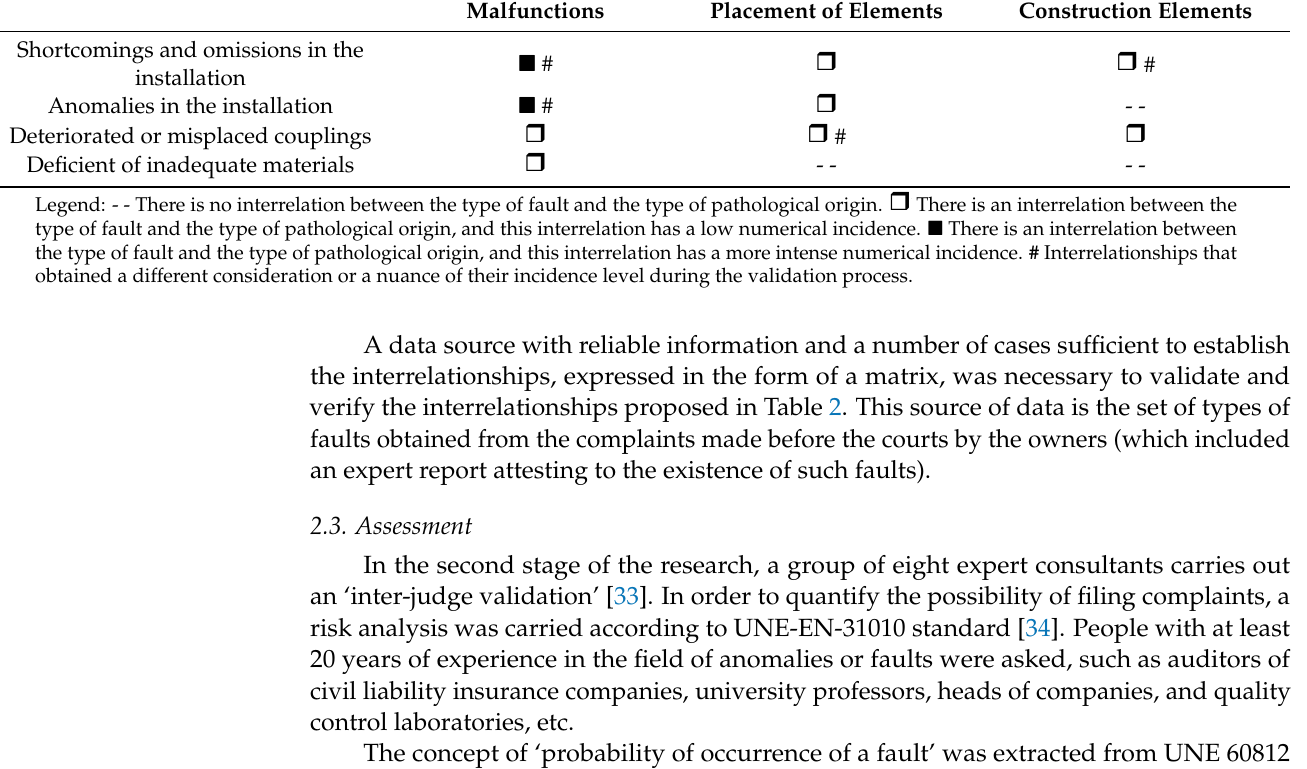
Legend: - - There is no interrelation between the type of fault and the type of pathological origin. There is an interrelation between the type of fault and the type of pathological origin, and this interrelation has a low nu- merical incidence. There is an interrelation between the type of fault and the type of pathological origin, and this interrelation has a more intense numerical incidence. # Interrelationships that obtained a different consid- eration or a nuance of their incidence level during the validation